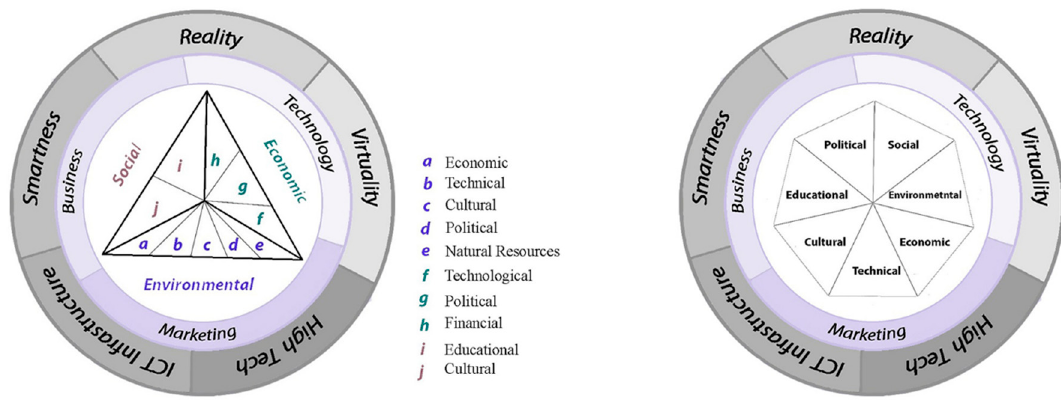
Figure 8. i -Sustainability Plus Theory Figure 8. i - Sustainability Plus Theory [8].